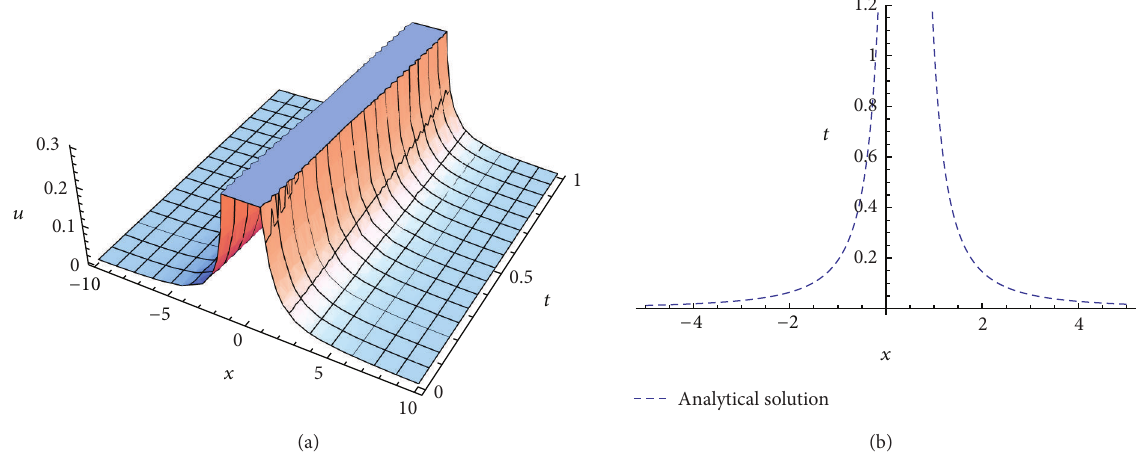
Figure 1: The solution (25) is shown at 𝑘 = 𝑤 = 1 , 𝐶 = 0.5 , and 𝐶 0 = 0.1 , and the second graph represents the exact analytical solution of (25) for 𝑡 = 0.5 .